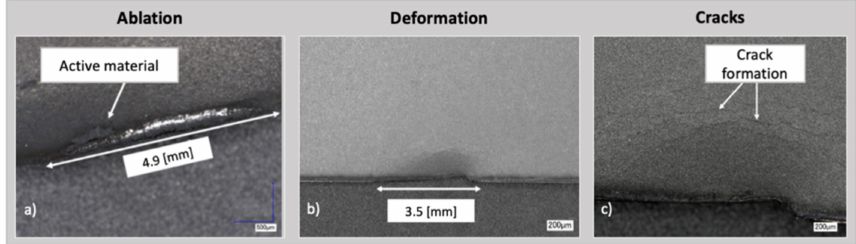
Figure 10. Visualized types of damage caused by the edge collision on a cathode